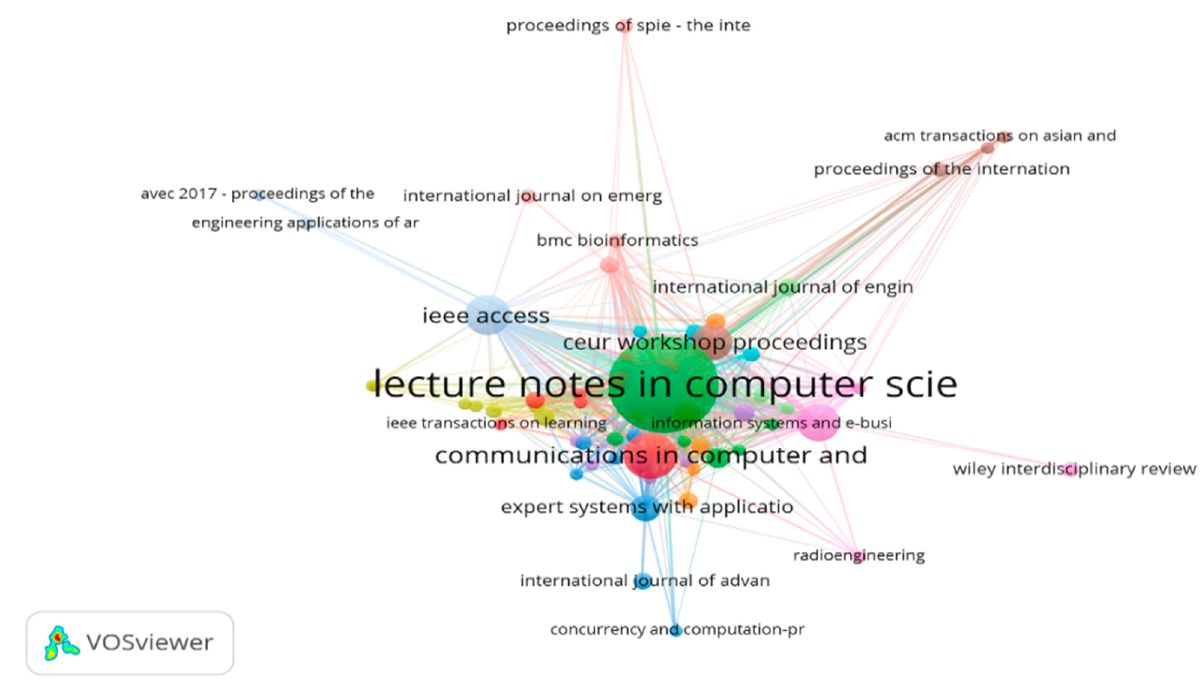
Table 22. Sources with bibliographic coupling, links, total strength links, and citations. Source Links